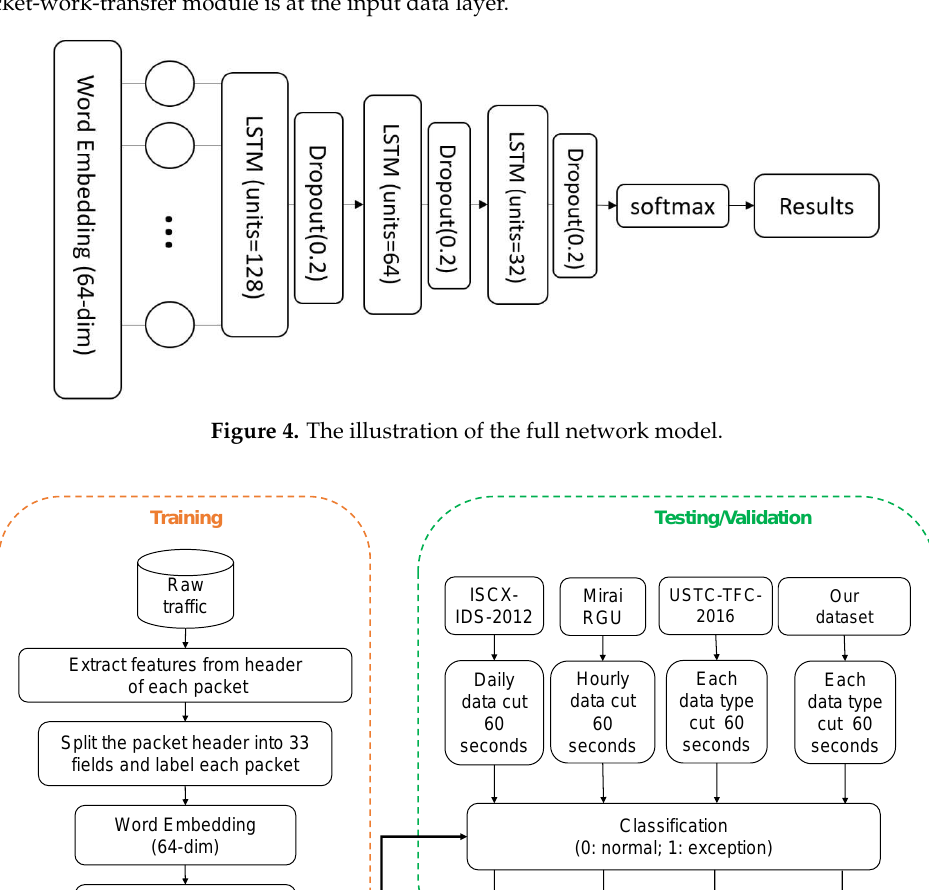
Figure 3. The illustration of the packet-word-transfer and classification module in the proposal. Packet-work-transfer module is at the input data layer.